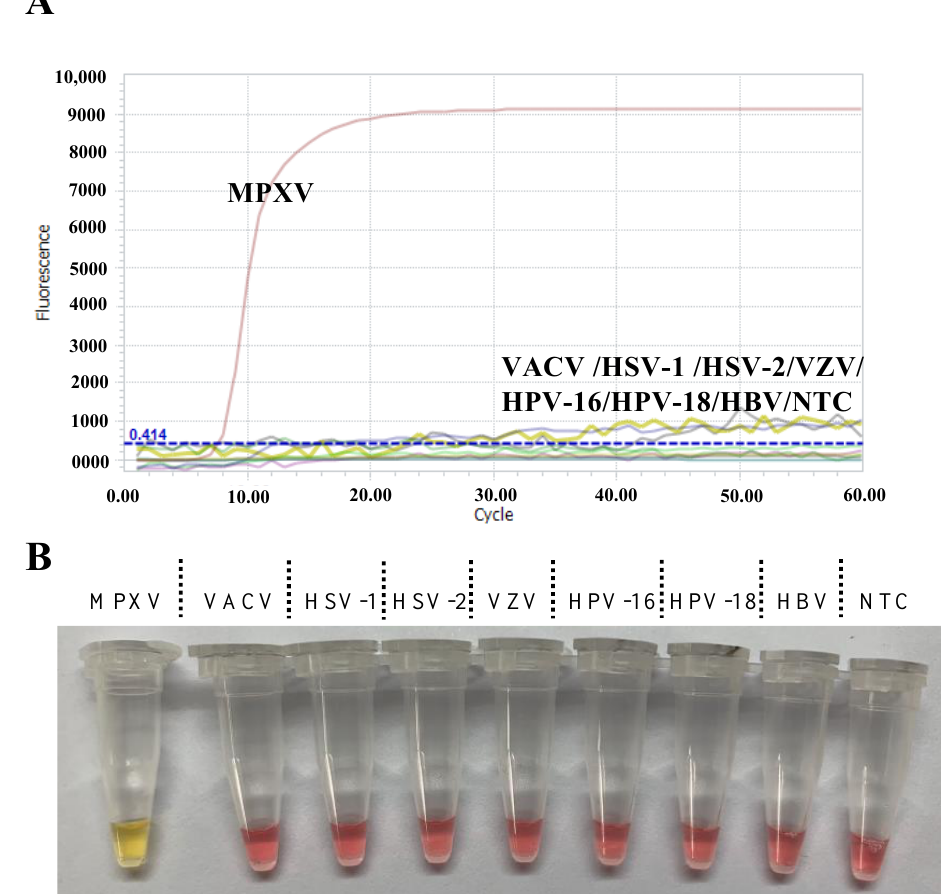
Figure 3. Specificity of the fluorescent LAMP ( A ) and visual LAMP assay ( B ). The DNA viruses used in the assay include: Varicella Zoster Virus (VZV); Hepatitis B virus (HBV); Vaccinia virus (VACV); Herpes simplex virus-1 (HSV-1); Herpes simplex virus-2 (HSV-2); Human papillomavirus-16 (HPV-16); and Human papillomavirus-18 (HPV-18). NTC: non-template